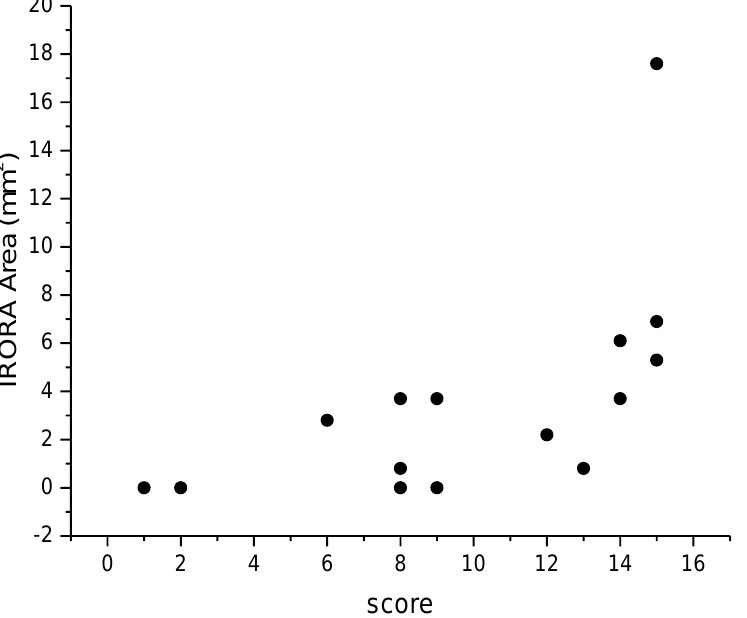
Figure 3. Results of correlation analysis between SRI and CS. SRI showed a positive correlation with CS. The r value is 0.5 ( p < 0.05).